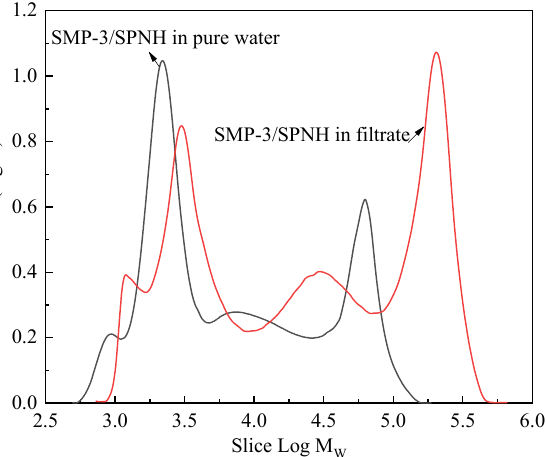
Figure 8. FITR spectra of SPNH, SMP-3, modified ZIF, and insoluble matter.